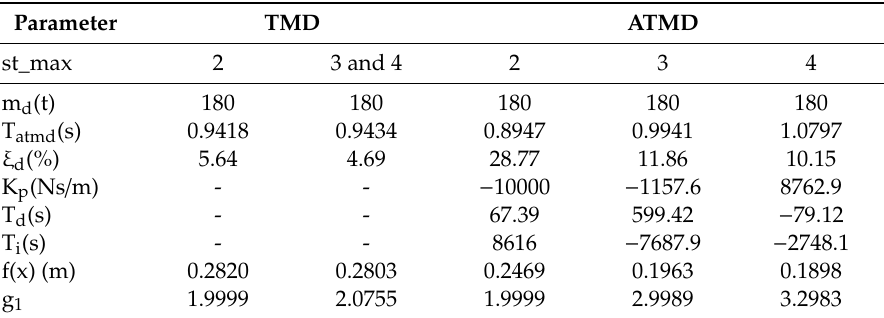
Table 3. The optimum